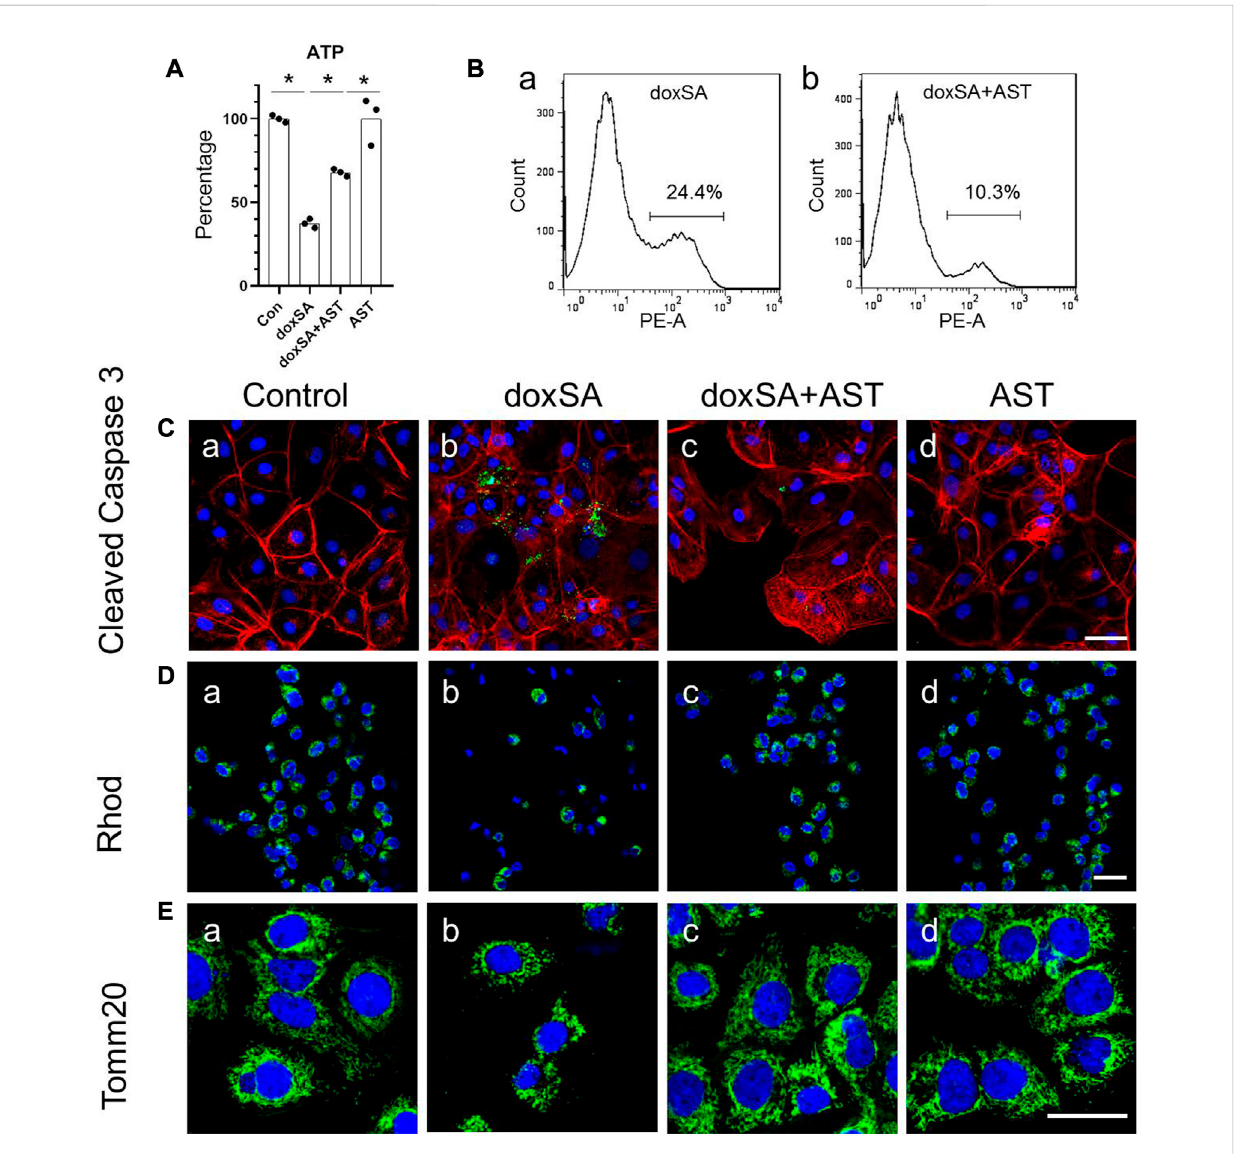
FIGURE 3 AST protected HK-2 cells from doxSA-induced mitochondrial damage. (A) doxSA-induced ATP depletion, (B) percentage of annexin-positive apoptosis in cells with (a) doxSA treatment and (b) doxSA treatment with AST. Representative images of (C) immunostaining for cleaved Caspase 3, (D) rhodamine uptake and (E) immunostaining for Tom20 in (a) control, (b) doxSA (5 μ M)-treated, (c) doxSA (5 μ M) +AST (200 μ M)-treated, and (d) AST (200 μ M)-treated cells have been shown. Scale bar = 100 μ